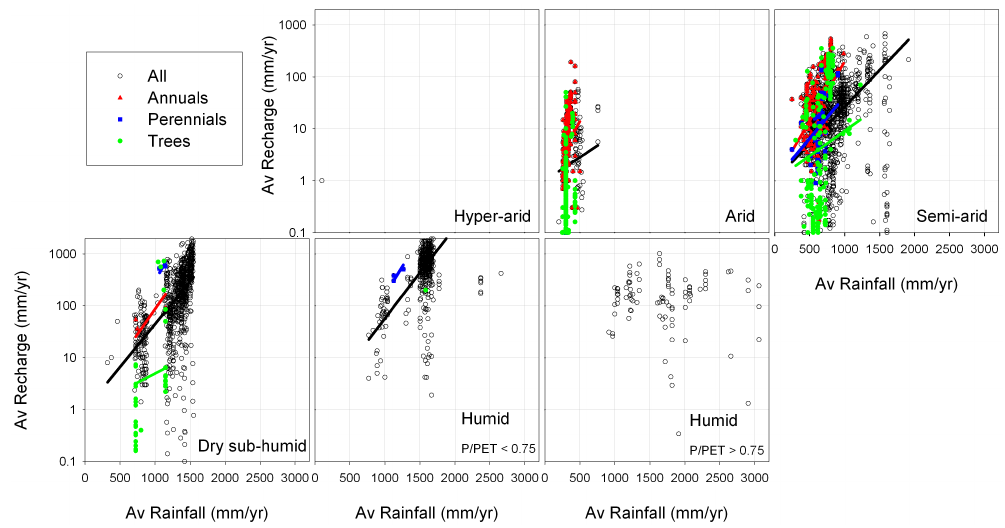
Fig. 8. The relationship between rainfall and recharge when the data is categorised based upon the aridity index. The class “all” is all the recharge estimates irrespective of vegetation type.